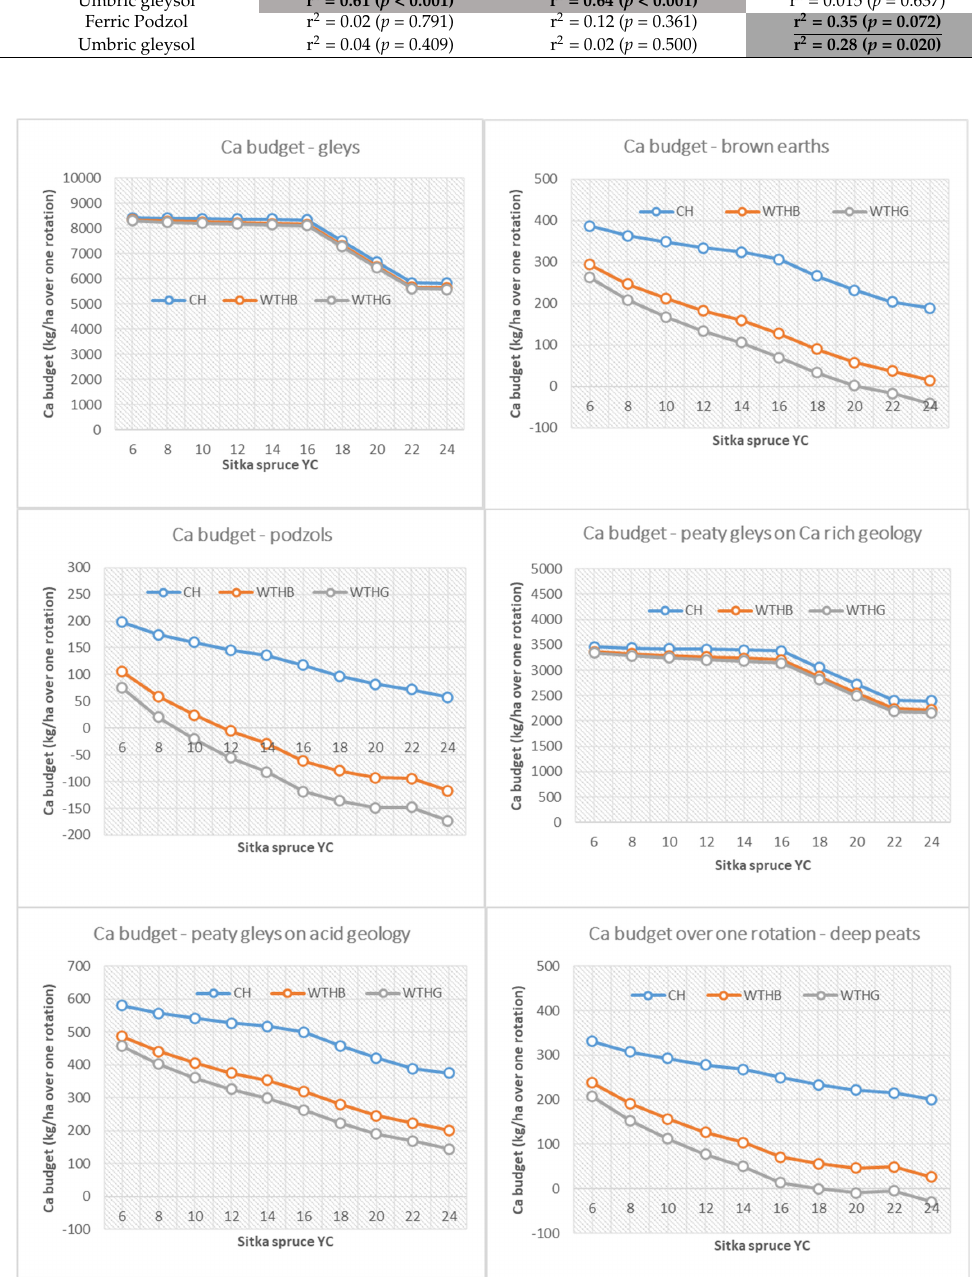
Figure 5. Forest Ca budget for Sitka spruce first rotation, YC 6-24, on six main forest soil types.